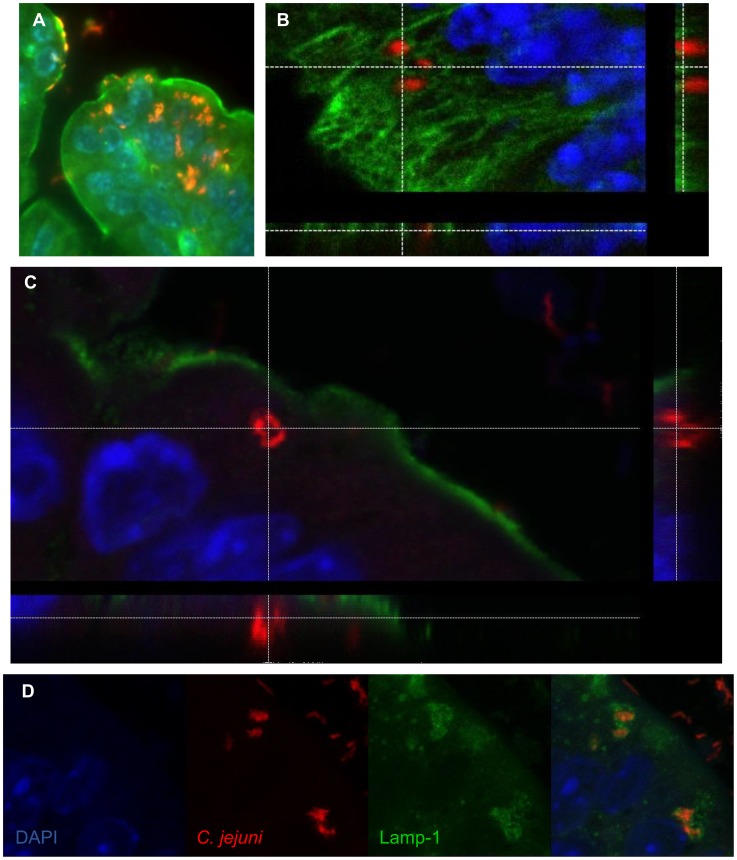
Immunofluorescent staining of intracellular C. jejuni in vivo.(A) Intracellular C. jejuni are visible in the cecal epithelium. C. jejuni (red), are visible against the β-actin (green) and the nuclei (DAPI, blue) of the cecal epithelium of a Sigirr−/− mouse, ×1000 magnification. (B) Confocal image of C. jejuni (red) present within epithelial cells of the colon of a Sigirr−/− mouse, highlighted against the Cytokeratin 19 of the cytoskeleton (green) and the nuclei (blue), with the z-stack cross-section indicating the C. jejuni within the cell. (C) Cross-section of a Z-stack, of a colonic epithelial cell of a Sigirr−/− mouse. The internalized C. jejuni (red) are clearly visible within the cytoplasm of the cell, as outlined by the β-actin (green) along the edge of the cell. (D) Internalized C. jejuni (red) co-localize with LAMP-1 positive (green) vesicles present within epithelial cells of a Sigirr−/− mouse colon.